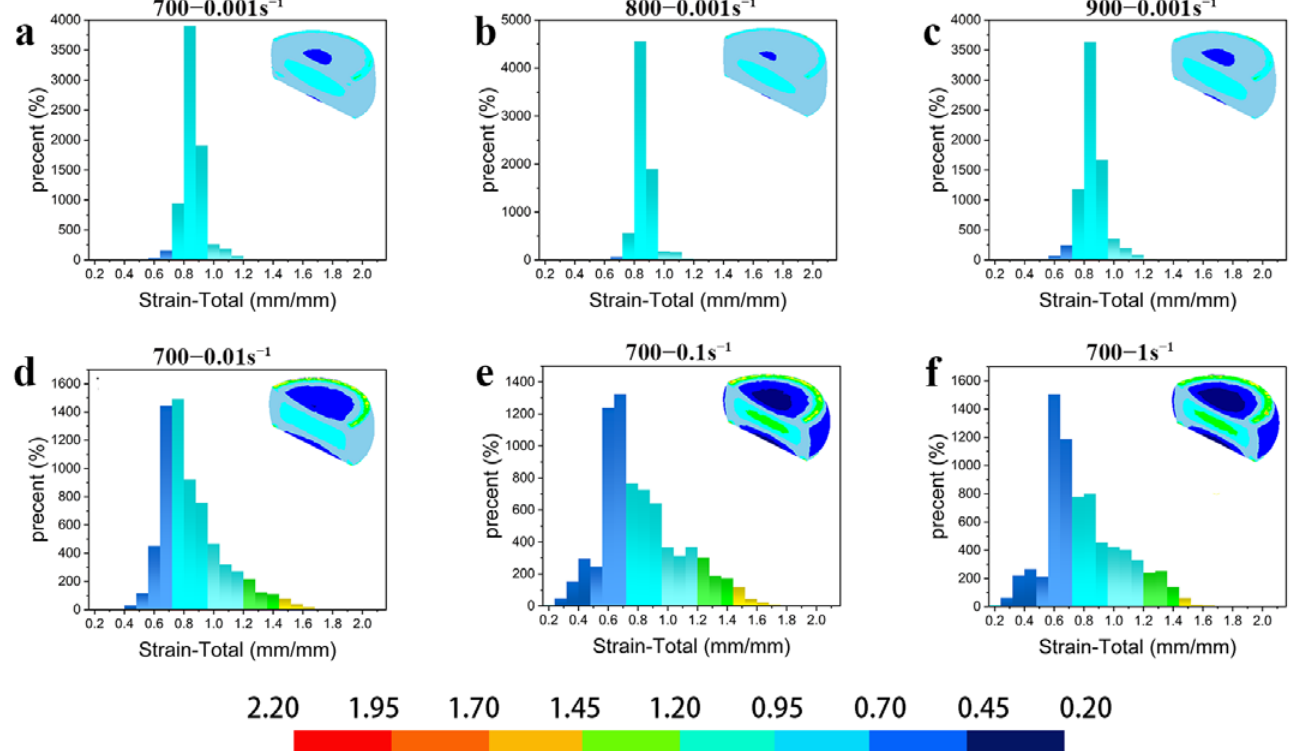
Figure 12. Simulation and prediction of the effective strain (100% of the true strain) distribution on half of the Cu − 9Ni − 6Sn under different deformation conditions: ( a ) 700 − 0.001 s − 1 , ( b ) 800 − 0.001s − 1 , half of the Cu − 9Ni − 6Sn under different deformation conditions: ( a ) 700−0.001 s −1 , ( b ) 800−0.001s −1 , ( c ) 900−0.001s −1 , ( d ) 700−0.01s −1 , ( e ) 700−0.1s −1 , ( f ) 700−1s −1 , respectively. ( c ) 900 − 0.001s − 1 , ( d ) 700 − 0.01s − 1 , ( e ) 700 − 0.1s − 1 , ( f ) 700 − 1s − 1 ,